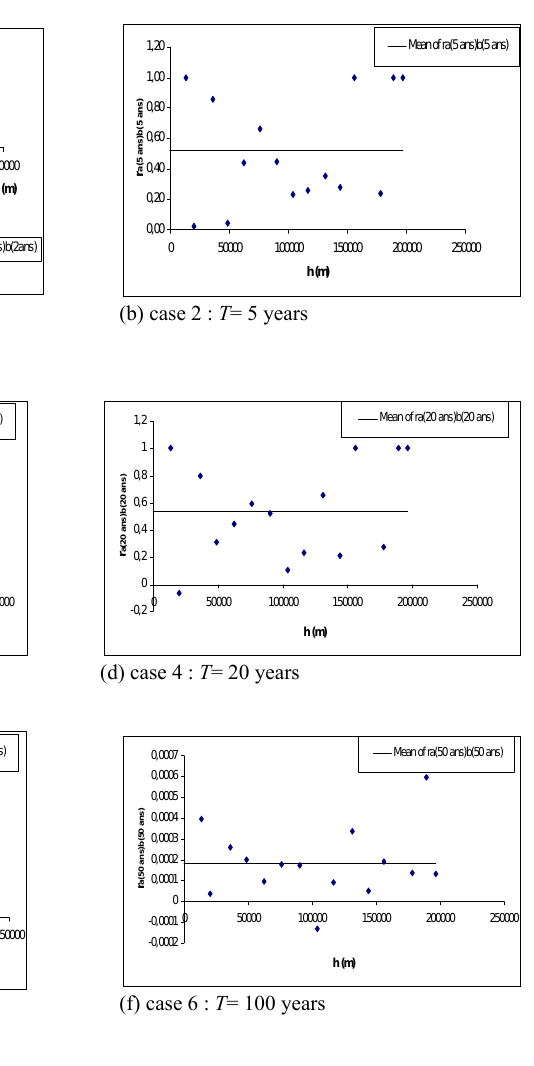
Figure 2. Fluctuation of r a(T)b(T) (h)